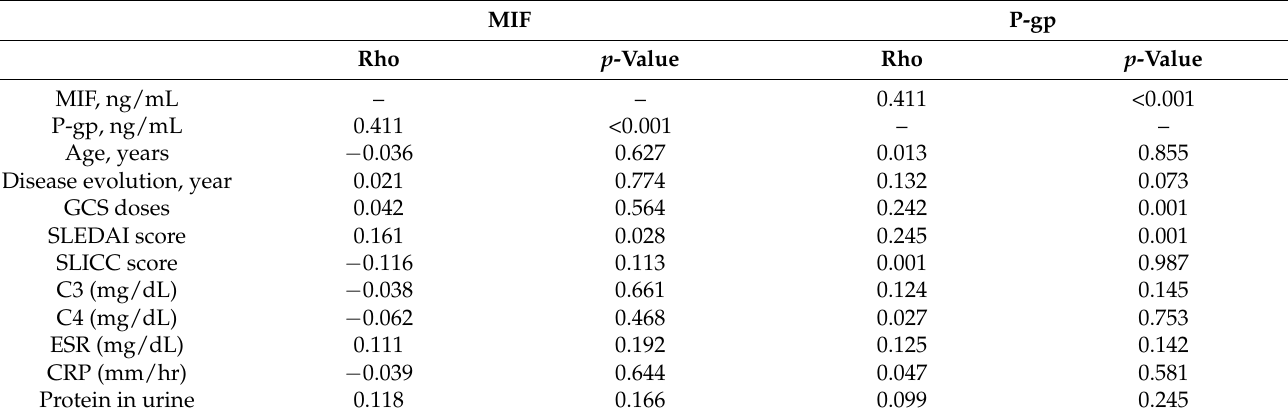
Table 2. Correlations between MIF, P-gp, and clinical variables in SLE patients. MIF P-gp Rho p